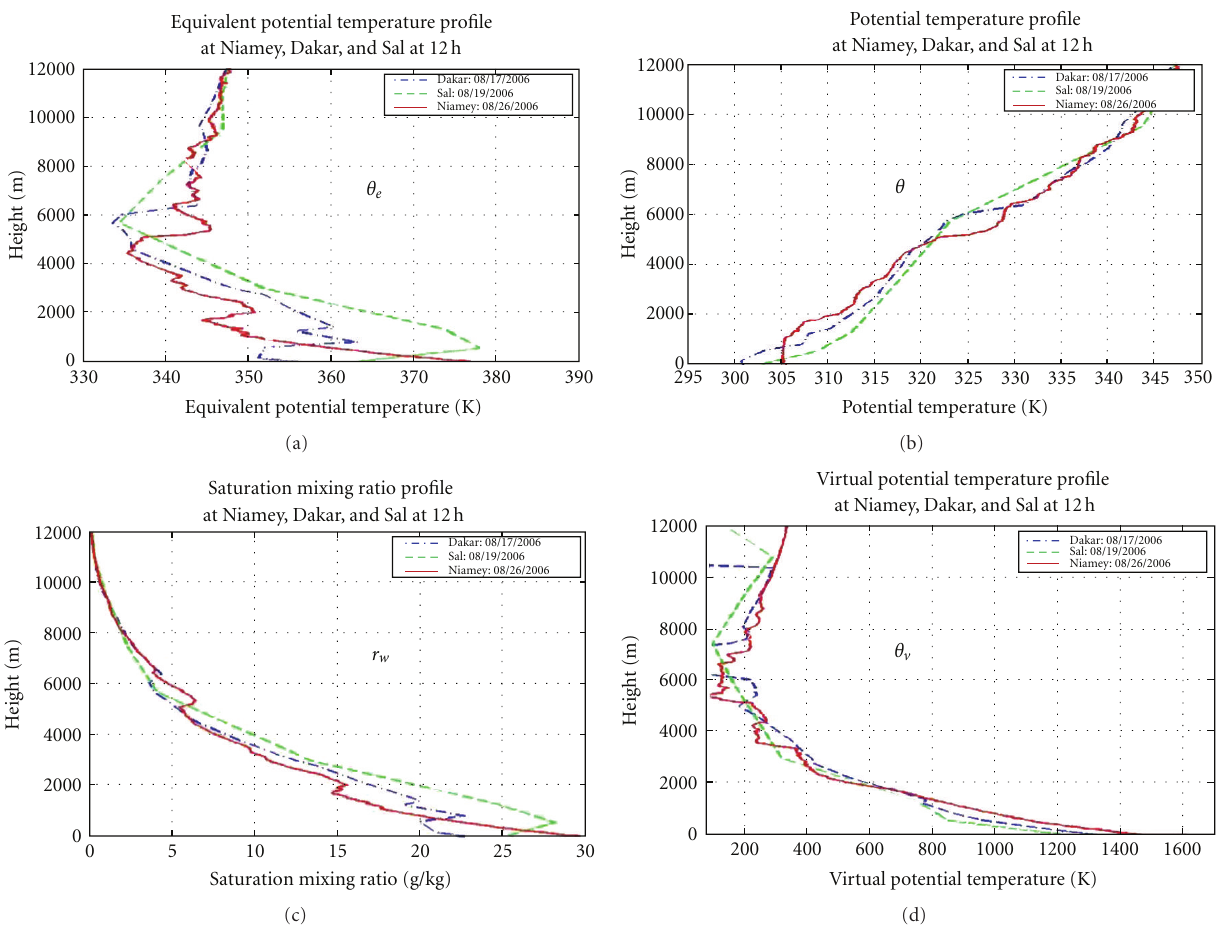
Figure 3: Profiles of virtual potential temperature θ v , potential temperature θ , equivalent potential temperature θ e , and saturating mixing ratio r w of the three case studies selected.